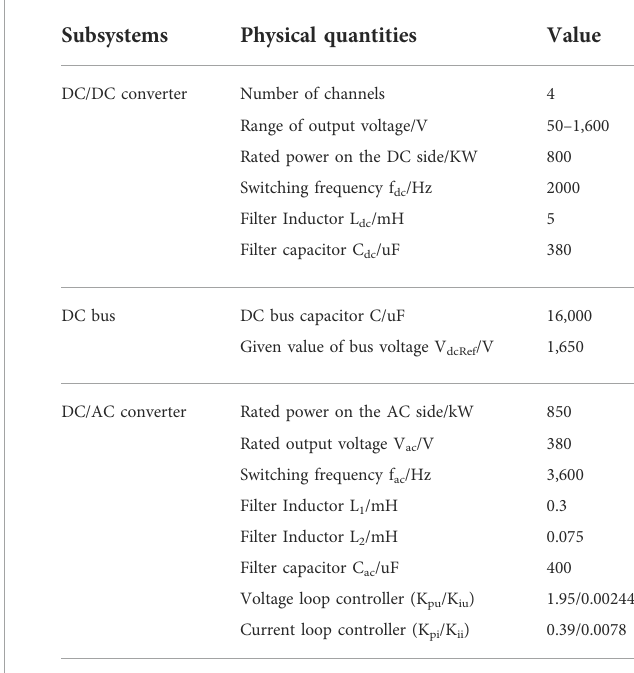
TABLE 3 Experimental system and controller